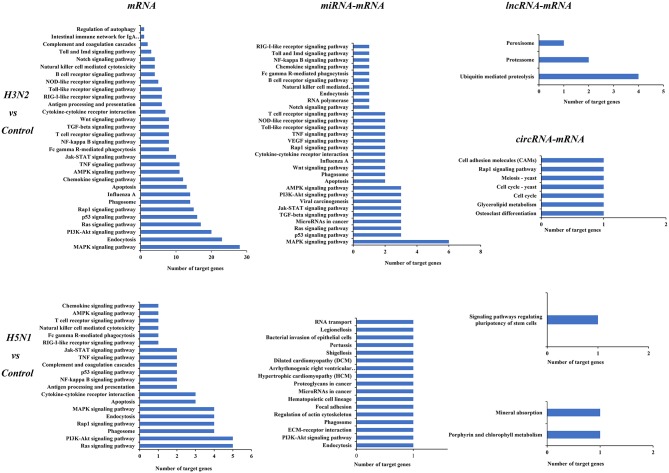
KEGG pathways of differentially expressed mRNAs and target genes of differentially expressed miRNAs, lncRNAs, and circRNAs. The horizontal axis shows the number of genes, and the vertical axis shows each pathway.